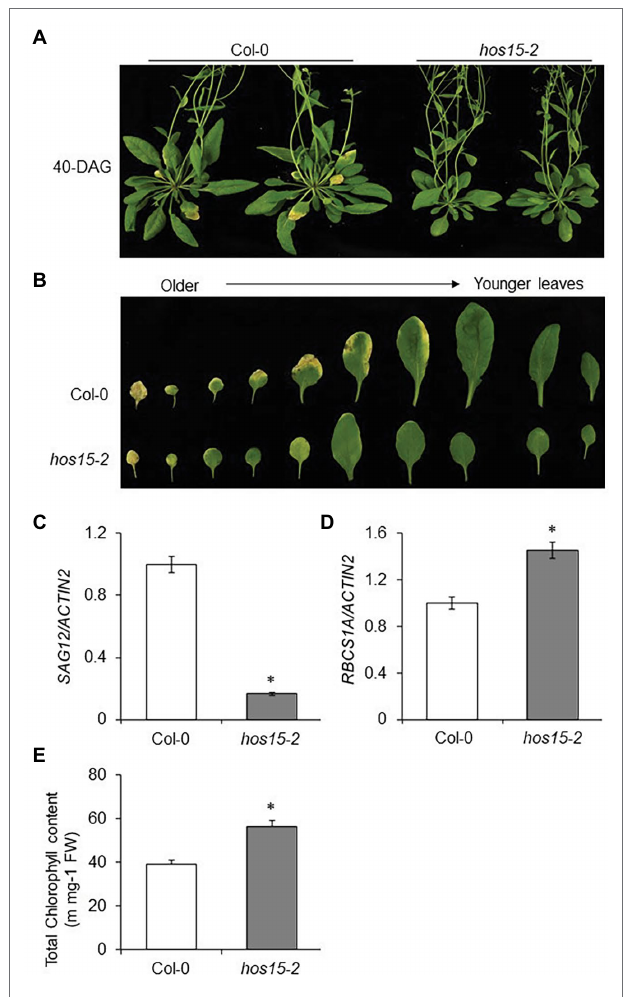
FIGURE 1 | The Arabidopsis hos15-2 mutant shows late senescence phenotype. (A) Comparative phenotypic analysis of Col-0 (WT) and hos15-2 plants after 40 days of germination. Seeds of Col-0 and hos15-2 were sterilized and germinated on MS medium for 10 days and then transferred to soil. Photographs were taken after 40 days of germination (DAG). (B) Phenotypes of rosette leaves of Col-0 and hos15-2 plants (3rd to 12th leaves) according to the sorted leaf age of 40 DAG. (C,D) Expression of SAG12 , a senescence marker gene, and RCBS1A , a photosynthesis-related gene in 3rd and 4th leaves of Col-0 and hos15-2 plants. Total RNA was extracted, and qRT-PCR analysis was performed. ACTIN2 was used as the internal control. Error bars show SD. Differences were determined via Student’s t -test (significance: * p < .05). (E) Leaves of the 4-week-old Col-0 and hos15-2 plants (3rd and 4th rosette) were used for total chlorophyll content measurement. Error bars show SD. Significant differences were determined via Student’s t -test (significance: * p <